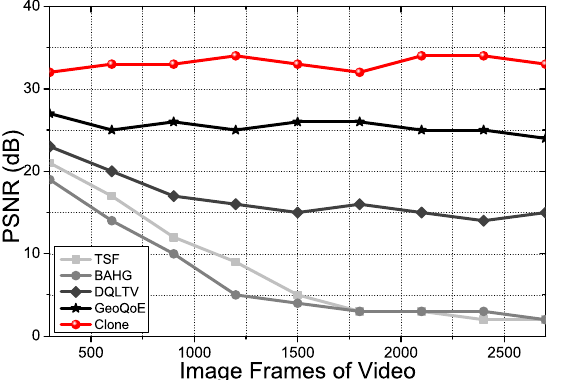
Figure 9. PSNR for the image frames of